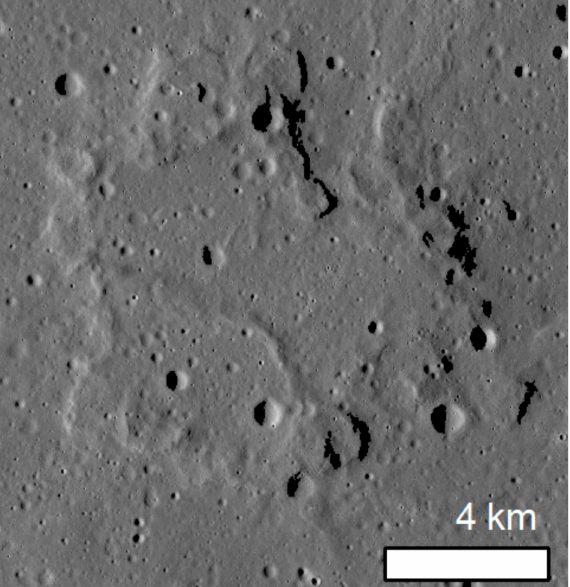
Figure 9. The largest dome (1.5 ◦ N, 53.7 ◦ E) in Mare Fecunditatis, shown with a TC